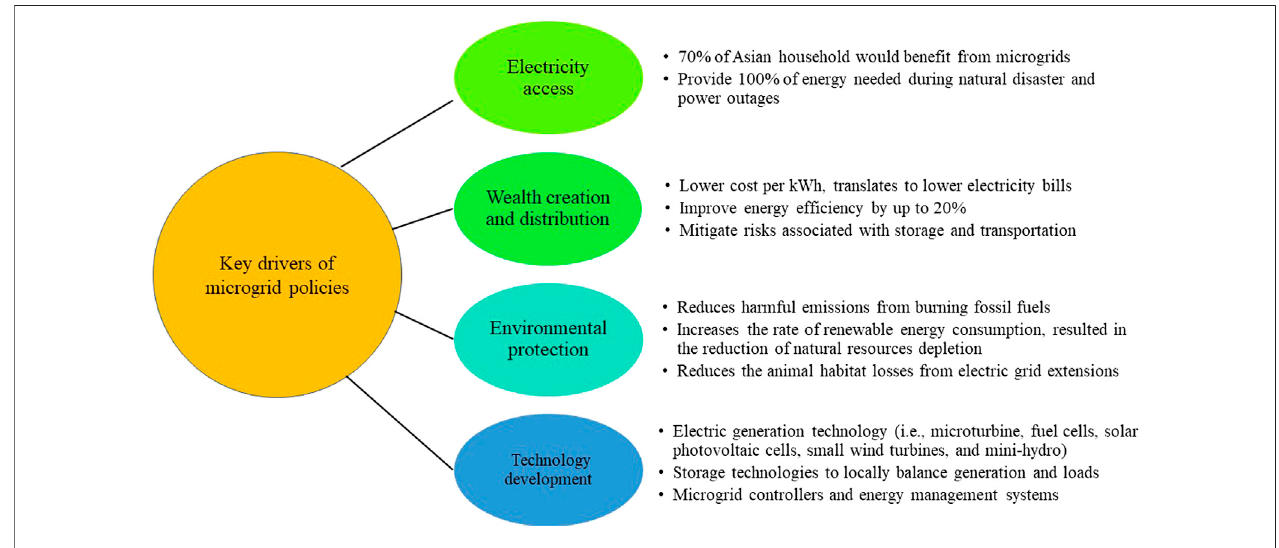
FIGURE 2 | Key drivers of microgrid